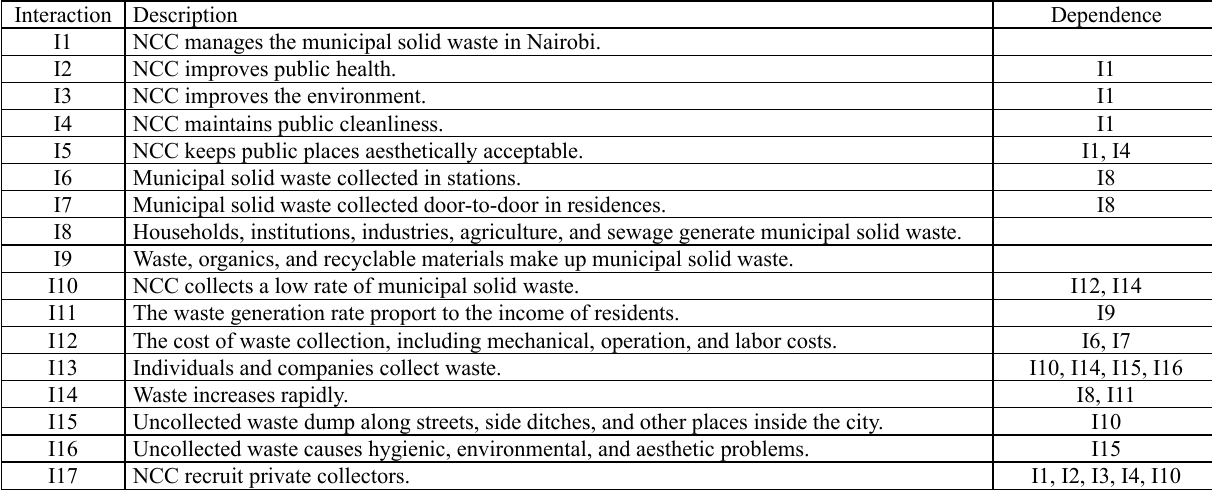
Table 8 . Interactions for manage MSW in